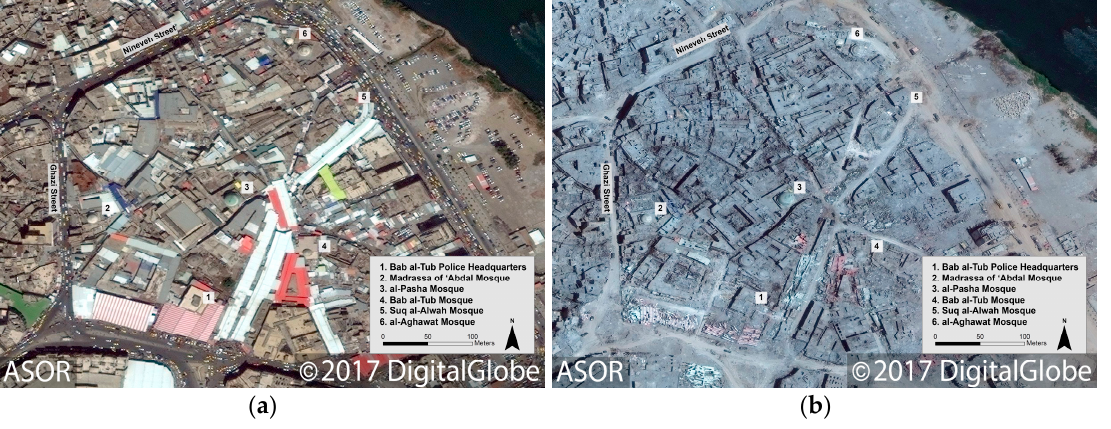
Figure 11. Density of damage to cultural heritage sites within the Old City of Mosul (ASOR CHI/DigitalGlobe NextView License; 12 July 2017).